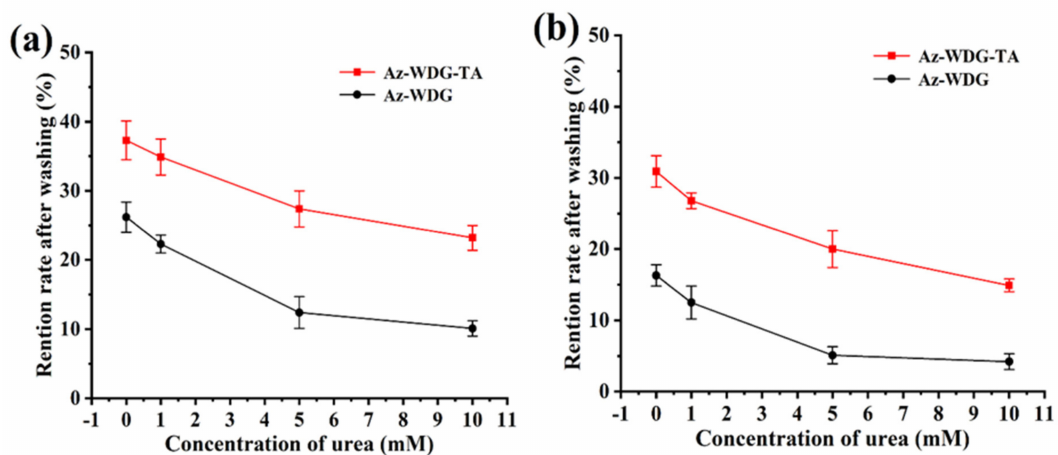
Figure 7. The retention rates variations of Az-WDG and Az-WDG-TA with di ff erent urea concentrations washing on the cucumber ( a ) and lettuce foliage surface ( b ).